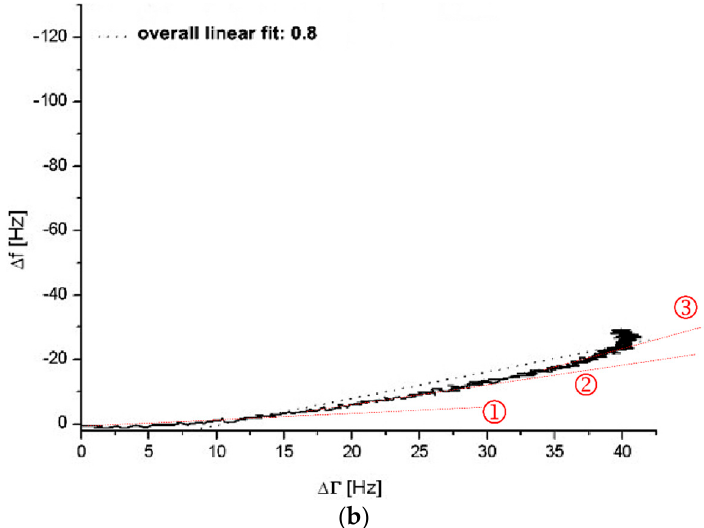
Figure 2. ∆ f vs. ∆Γ diagrams without ( a ) and with ( b ) incubation of the quartz surface with 1:10 diluted healthy donor’s PPP (donor III). In figure ( a ) and ( b ) a coagulation measurement (PPP + thrombin reagent, 1:10 diluted) was run for 900 s. Grey dotted lines show overall linear fit. Red dotted lines marked with (cid:192) , (cid:193) and (cid:194) show different linear fits during different stages of the coagulation process.